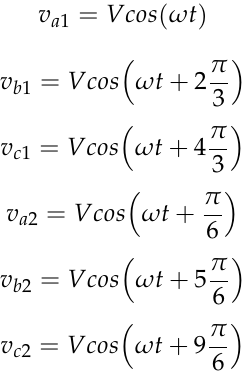
Figure 2. Symmetrical six-phase output.